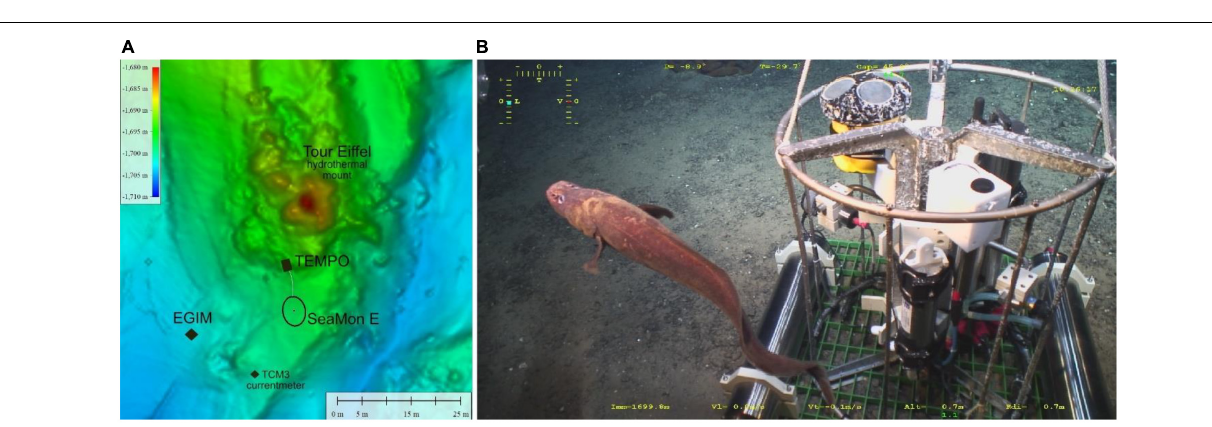
FIGURE 7 | (A) Map of the Tour Eiffel area at Lucky Strike (mid-Atlantic ridge) showing the location of the EGIM and the components of the EMSO-Azores observatory; (B) the